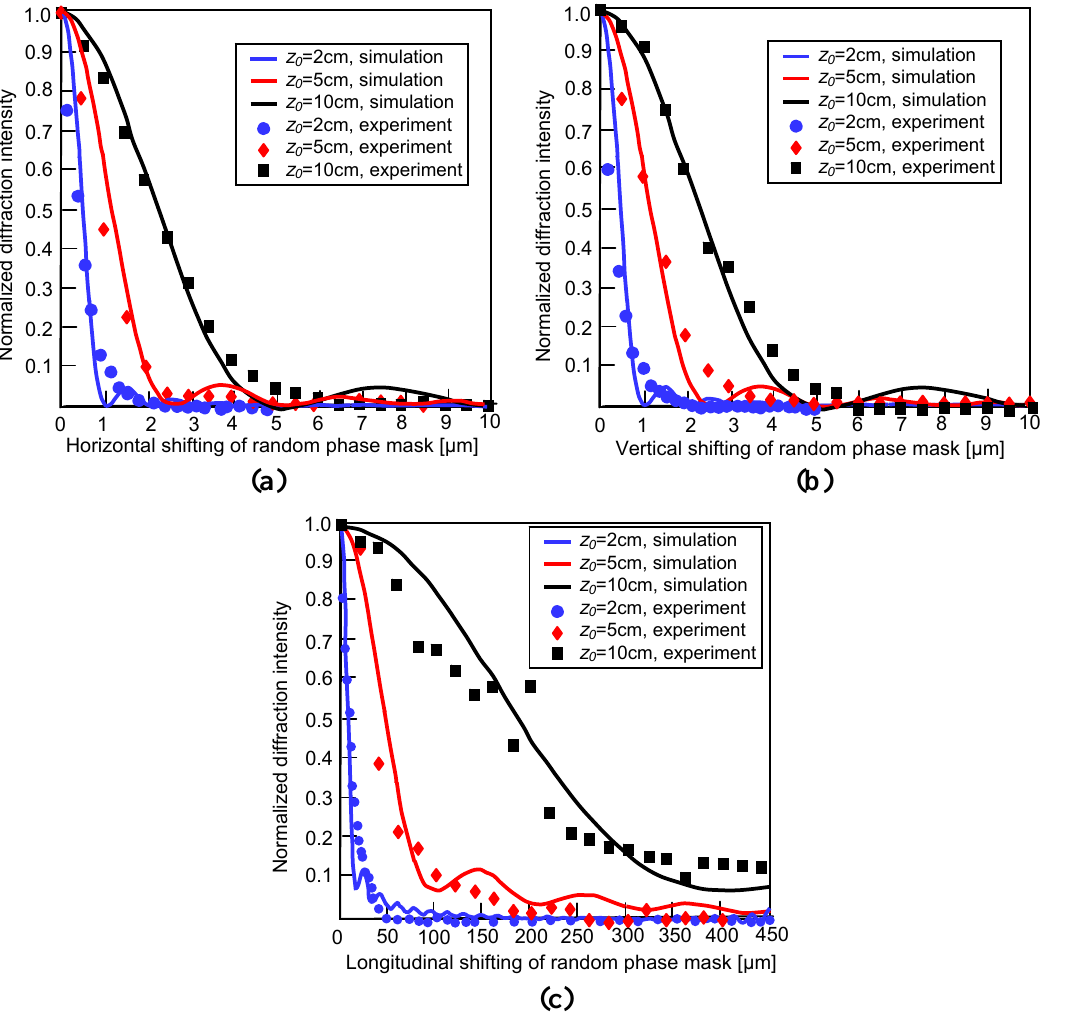
Figure 7. Diffraction selectivity of the ground glass for holographic storage of encrypted